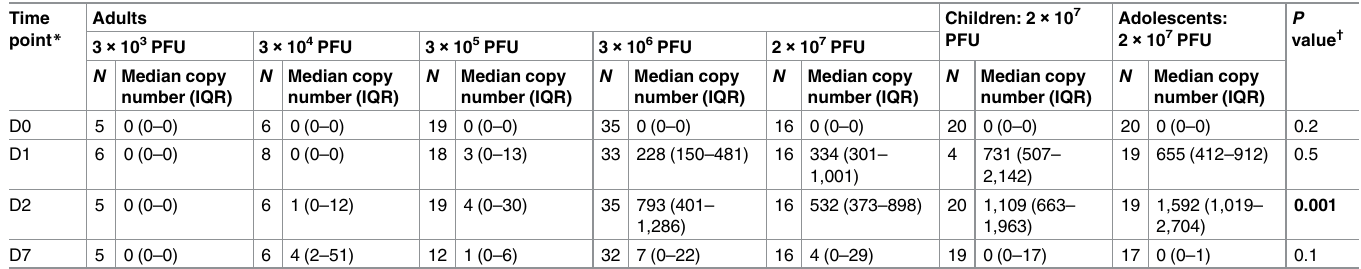
Table 8. Description of viraemiaby dose and age.